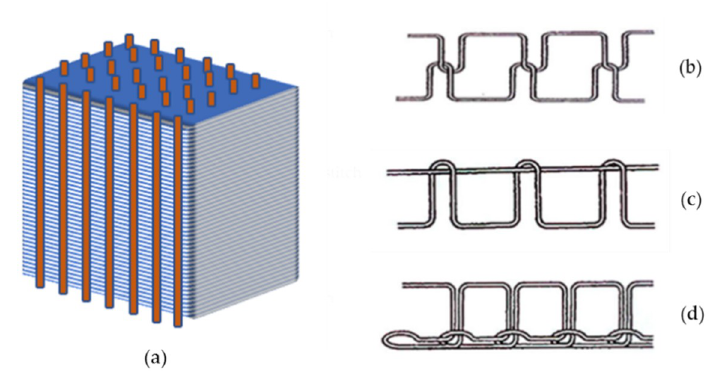
Figure 9. Different reinforcement stitching techniques: ( a ) Z‐pinning [©MB, JA, MAM_UC3M2020], ( b ) lockstitch, ( c ) modified lockstitch, ( d ) chain stitch. Adapted from [200].